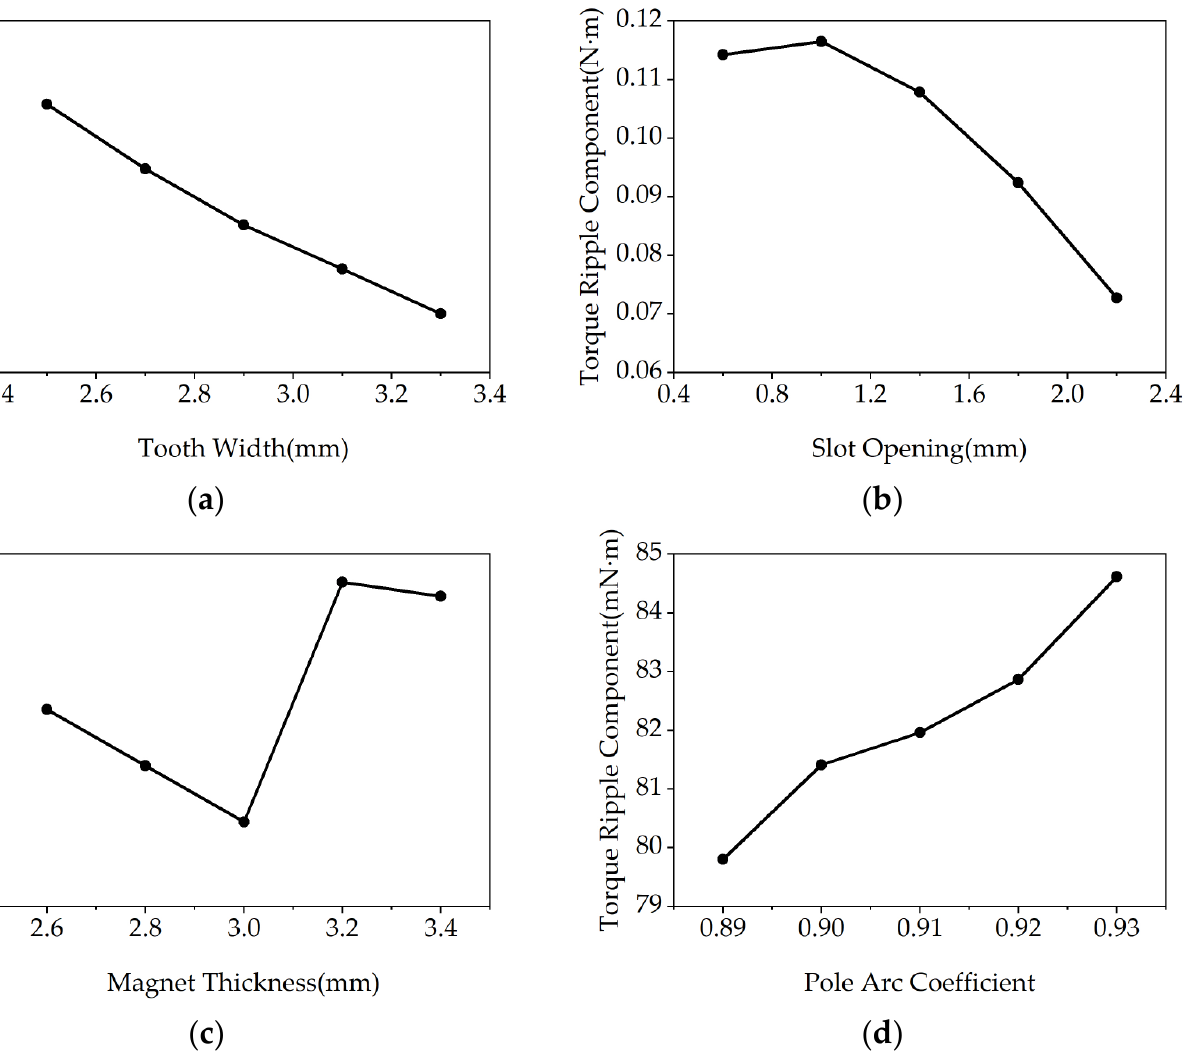
Figure 3. Influence of constant rotor parameters on load torque fluctuation components. ( a ) Tooth width; ( b ) slot opening; ( c ) magnet thickness; ( d ) pole arc coefficient.